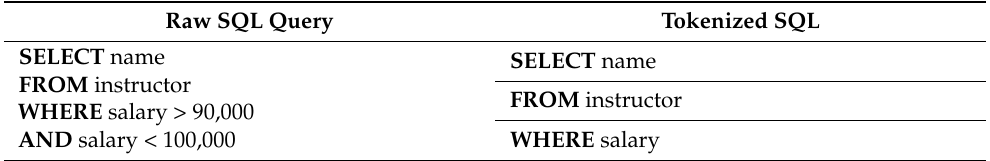
Table 1. An example of SQL query tokenization.